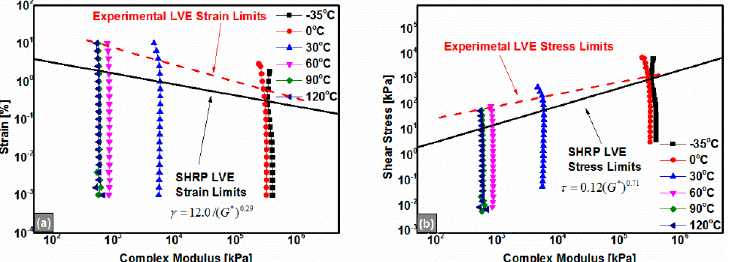
Figure 3. Strain sweep results of the anhydrides-cured bimodal REAC (take 180# for an example); ( a ) Strain vs. complex modulus (| G *|); ( b ) Shear stress vs. complex modulus (| G *|). All the anhydrides-cured bimodal REACs had the similar LVE limits.